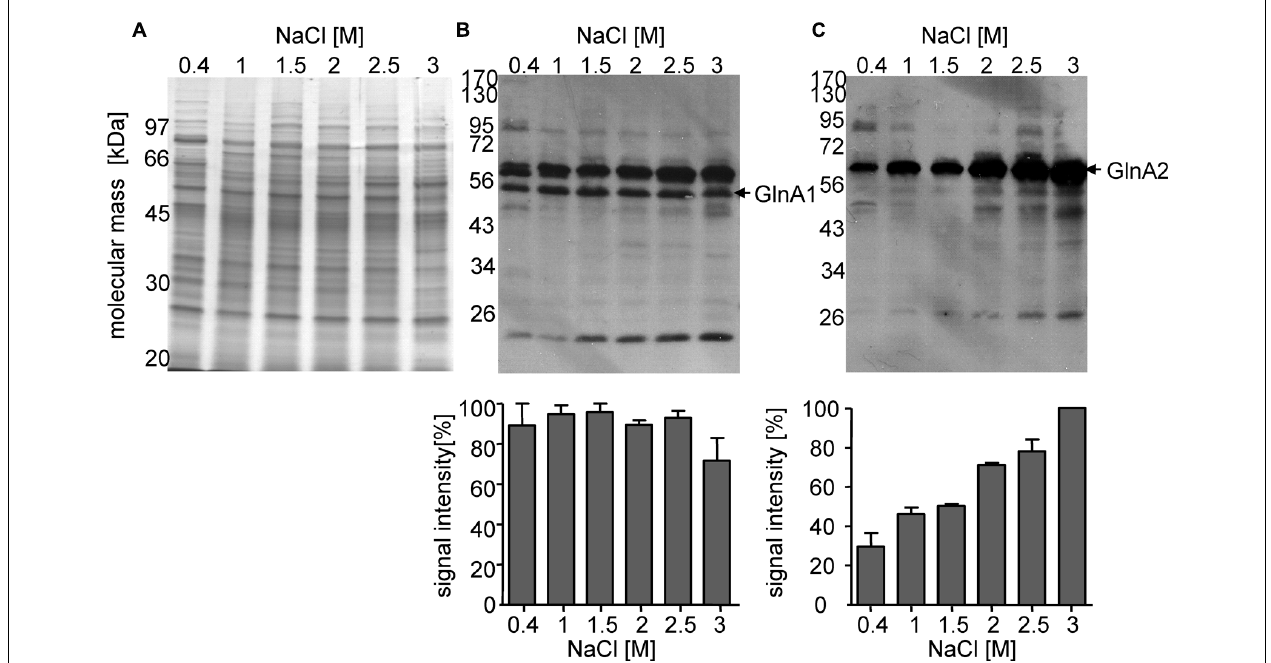
cultures. A Coomassie blue-stained SDS-Page containing 20 μ g protein per lane (A) .Western blot analysis using specific antibodies against GlnA1 (B) and GlnA2 (C) showing the cellular concentration of GlnA1 (B) and GlnA2 (C) , respectively, in dependence of salinities in the growth media. Averaged values of two independentWestern blot analyses are given in the lower panel.The highest signal intensities were set to